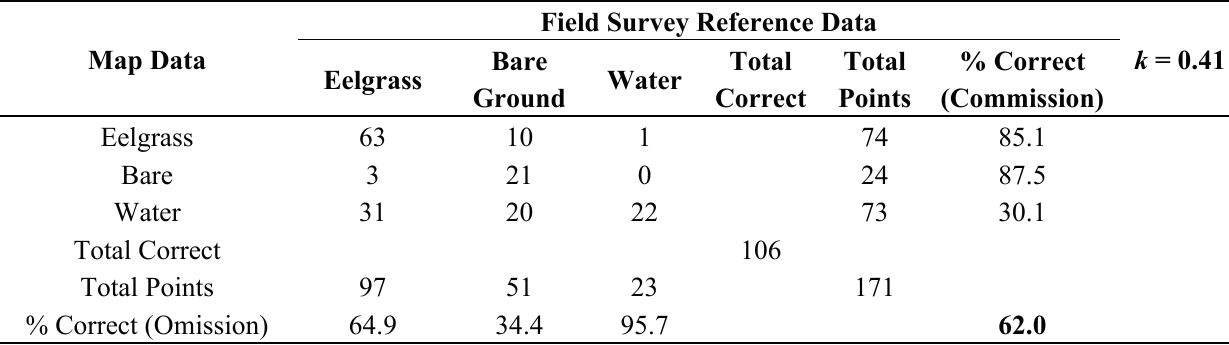
Table A13. Rationalized product for classification of habitats in Kinzarof